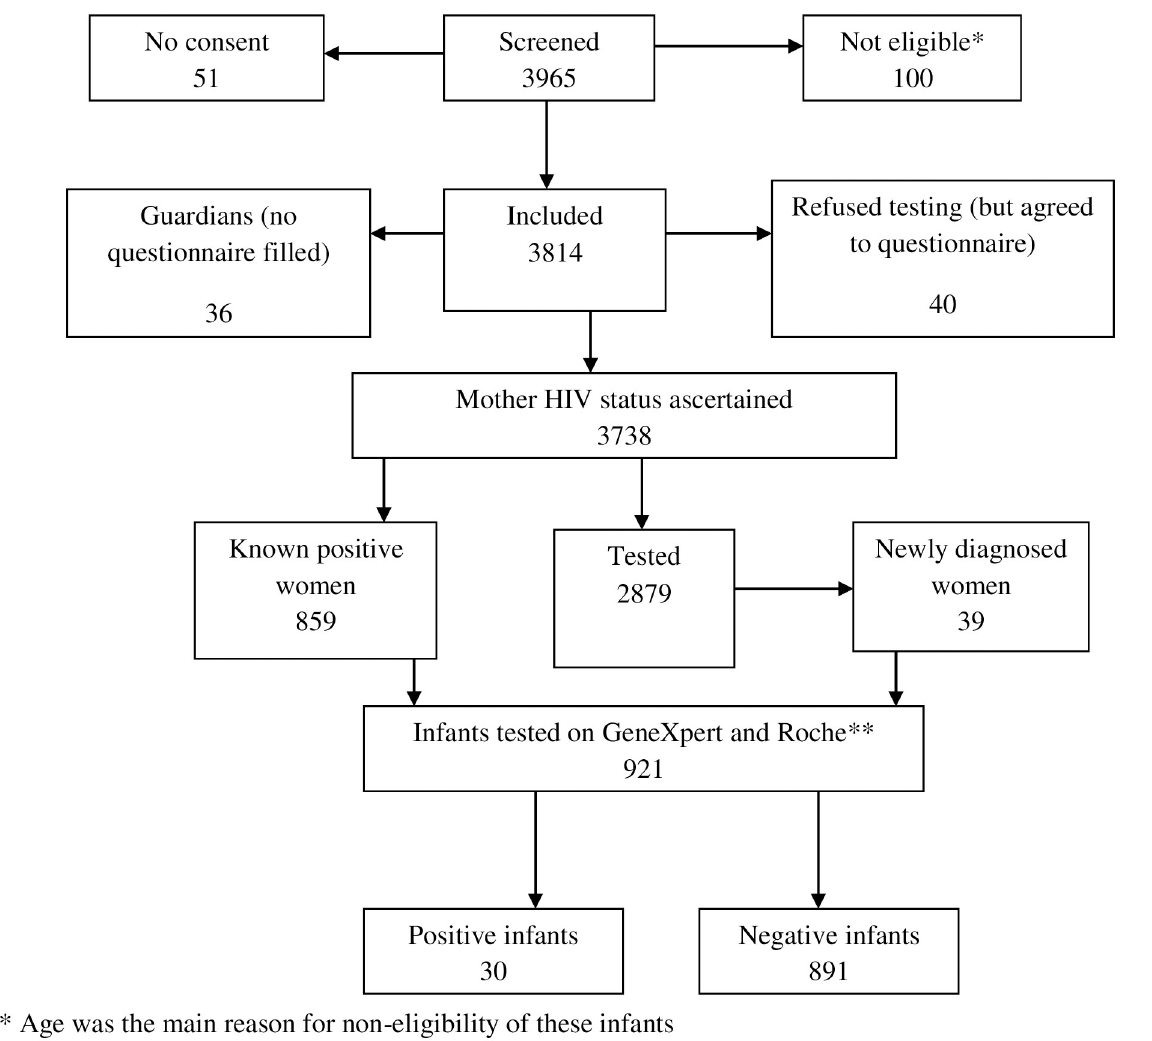
Fig 1. Inclusion flow chart It shows the characteristics of the study population, including children and women who were part of the study.